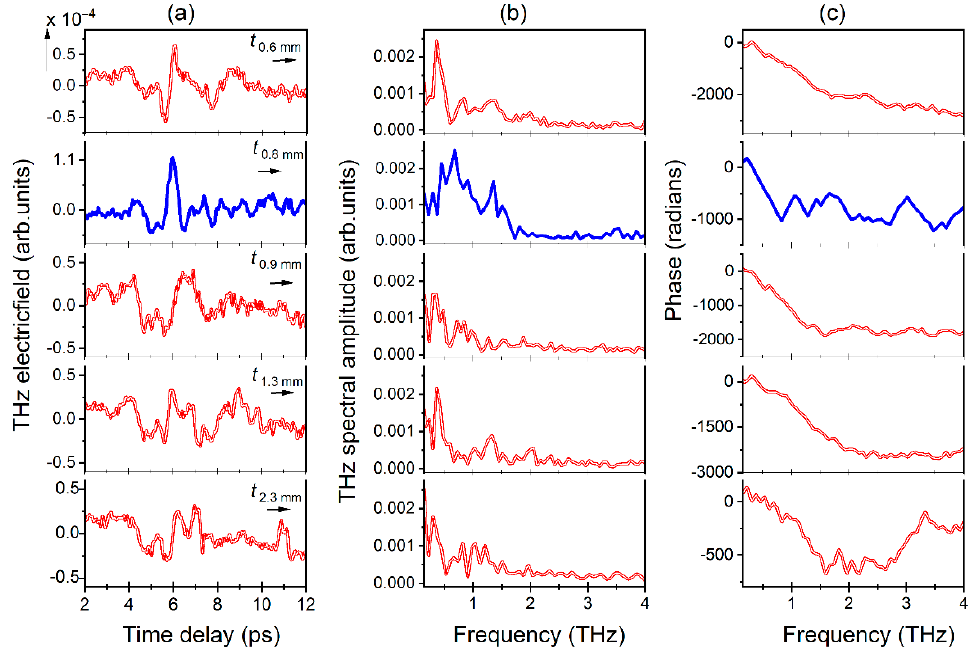
Figure 9. THz temporal profiles ( a , second panel) using reference 1 MAPbI 3 (0.8 mm), and reference 2 measured after transmission from 0.6, 0.9, 1.3, and 2.3 mm MAPbI 3 (a, 1,3,4,5 panels top to bottom) PSCs. After FFT: ( b ) spectral amplitude; ( c ) phase of transmitted THz pulse corresponding thickness of MAPbI 3 shown in ( a ).